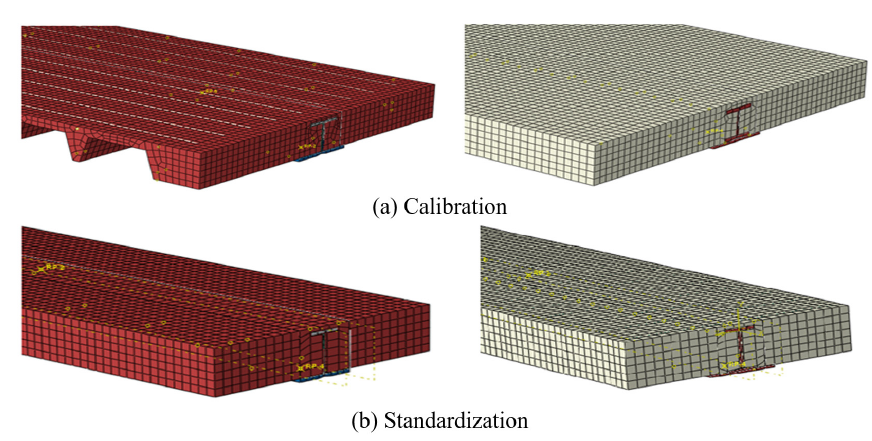
Figure 14. Model meshing.